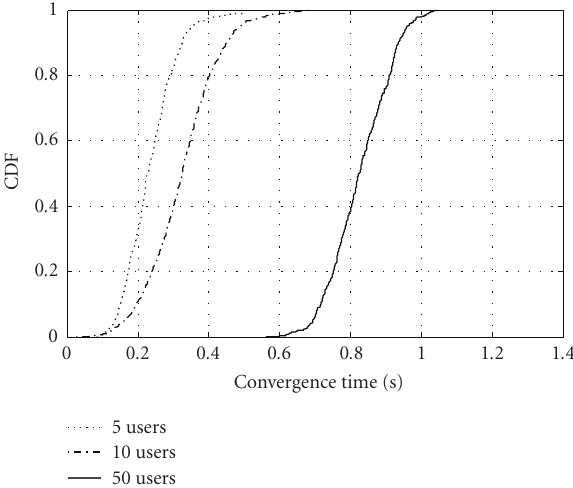
Figure 15: CDF of convergence time with greedy algorithm.